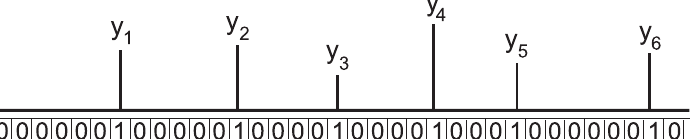
Figure 1: High-dimensional boolean representation of a theoretical spectrum containing